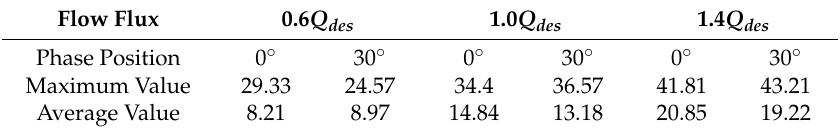
Table 6. Fluid incidence angle on the interface between impeller and exit chamber. Unit: Degree.